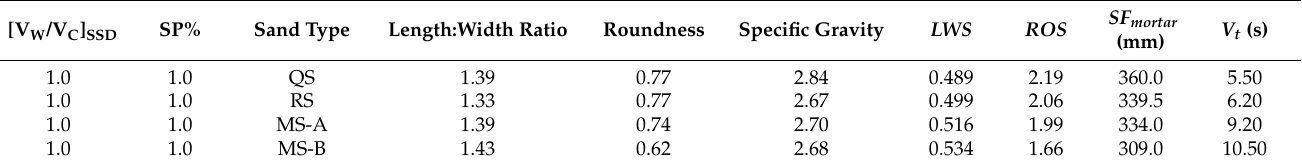
Table 4. Shape parameters and the test results of mortar of four kinds of sands